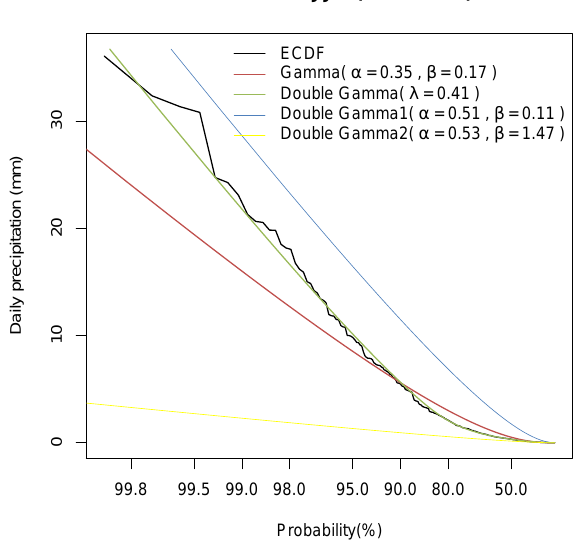
Figure 2. CDF plot comparing a gamma distribution (red) and a double gamma distribution (green), which consists of two gamma distributions (blue and yellow) fitted to the same precipitation data for one study catchment. The empirical distribution is shown in